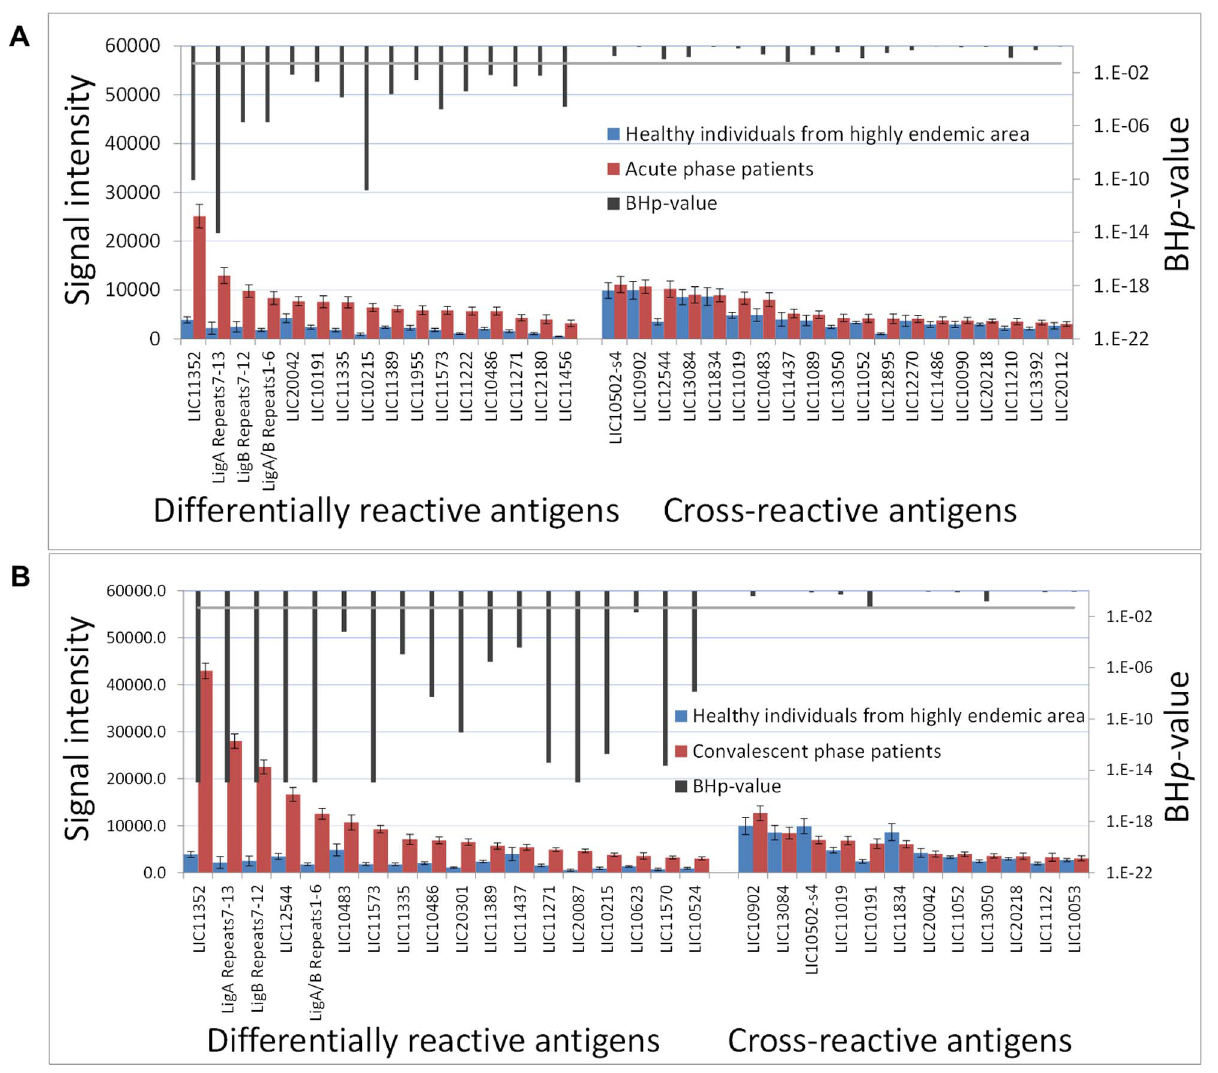
Figure 2. Seroreactive antigens identified for acute- and convalescent-phase patients. The histogram plots the average signal intensity (Y axis) of each antigen (X axis) for acute (A) or convalescent (B) groups against healthy individuals from highly endemic area group, with the BH p -value of this difference (black bars, secondary axis). Differentially reactive antigens (BH p , 0.05) are organized to the left; cross-reactive antigens (BH p . 0.05) are organized to the right. Error bars indicate S.E. For plotting the histograms, it was assigned the number 10 2 16 for BH p -values ,